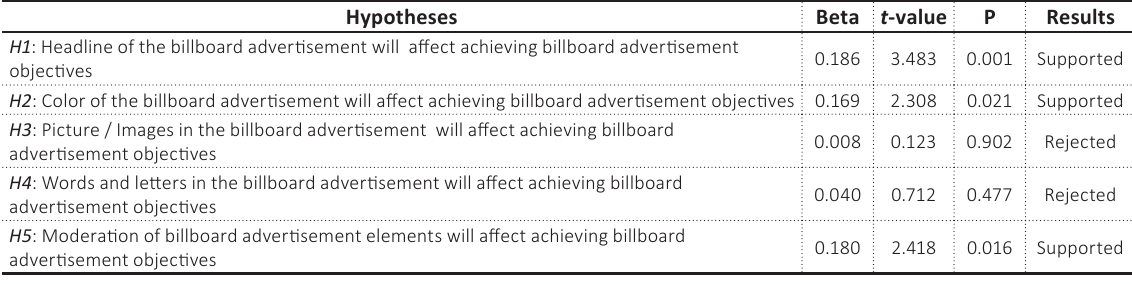
Table 4. Research hypotheses results (direct path)